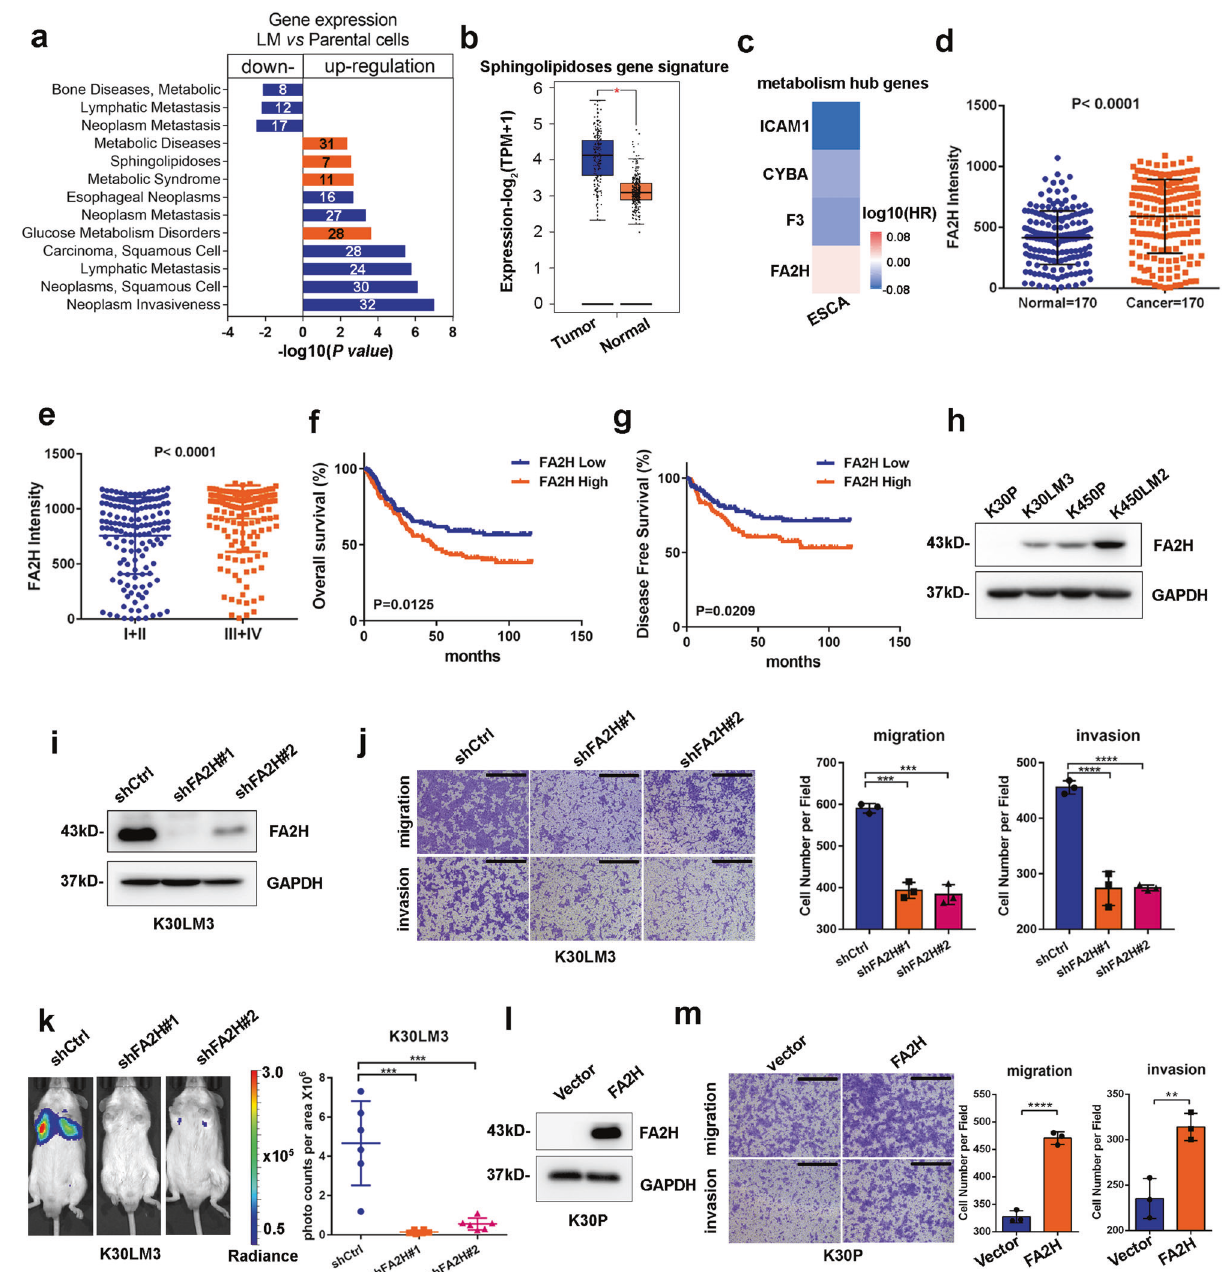
Fig. 2 The function of FA2H in promoting ESCC metastasis. a Genomatix Disease Pathways analysis of co-regulated genes in LM cells relative to parental cells. b Sphingolipidoses gene signature is signi fi cantly enriched in TCGA Esophageal Cancer (ESCA) tumors. c A heatmap showing hazard ratios of disease-free survival between the top quarter and the bottom quarter of four metabolism-related hub genes expression in ESCA datasets. d Statistical analysis of FA2H staining intensity in 170 paired adjacent and ESCC tissues. e Statistical analysis of FA2H staining intensity between early-stage (I and II) and late-stage (III and IV) ESCC tumors (n = 306). f , g Kaplan – Meier analysis of overall survival ( f ) and disease-free survival ( g ) in ESCC patients with high or low FA2H expression ( n = 306). The high or low expression of FA2H or FOXC2 in Kaplan – Meier analysis was strati fi ed by median FA2H or FOXC2 protein levels from IHC staining quanti fi cations. h Western blotting analysis of FA2H expression between LM cells and parental cells. i The FA2H knockdown ef fi ciency was analyzed by western blotting in K30LM3 cells. j Transwell assay was performed to evaluate the effect of FA2H silencing on migration and invasion ability of K30LM3 cells. Scale bar, 500 µm. k Bioluminescence quanti fi cation of lung colonization by K30LM3 cells expressing shRNA targeting FA2H or a control hairpin (shCtrl). l Ectopic expression of FA2H in K30P cells was examined by Western blotting. m Transwell assay was performed to evaluate the effect of FA2H overexpression on migration and invasion ability of K30P cells. Scale bar, 500 µm. Error bars denote mean ± SD. * P < 0.05, ** P < 0.01, *** P < 0.001, **** P < 0.0001